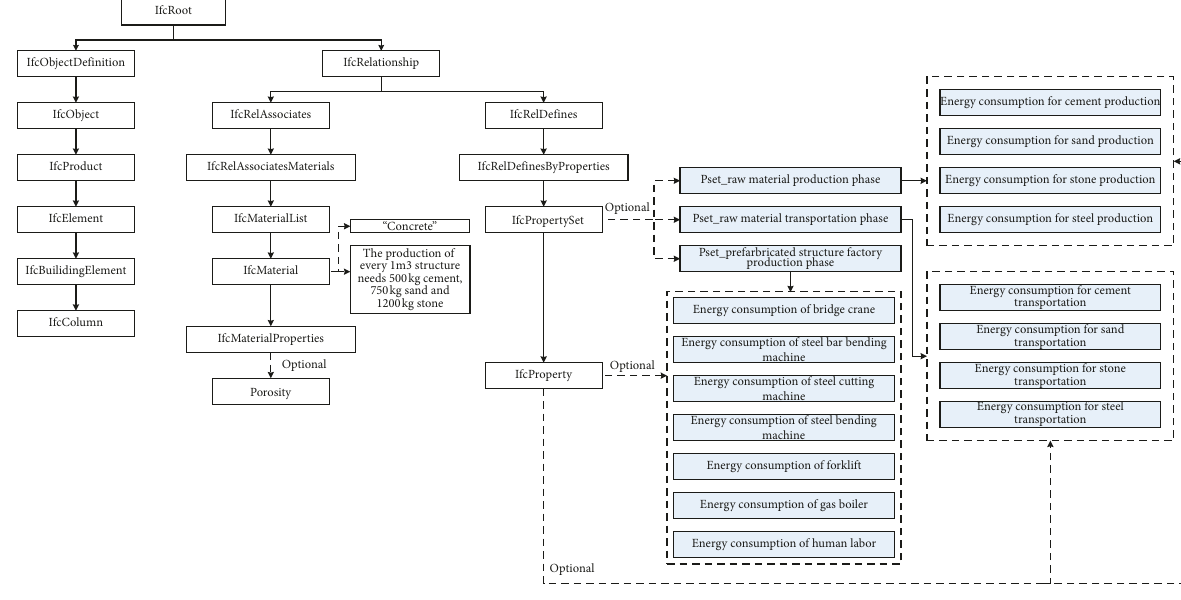
Figure 8: The IFC extension of material and energy consumption